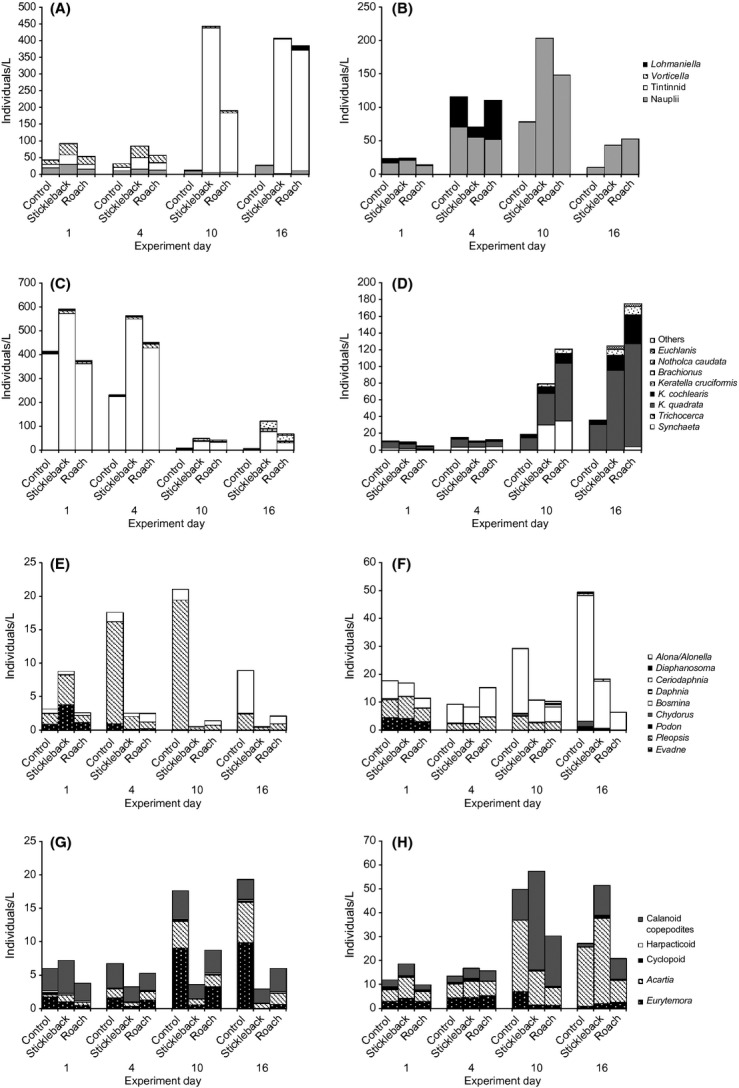
Mean total abundances of zooplankton in each treatment (control, stickleback, roach) on days 1, 4, 10, and 16 of spring (A, C, E, and G) and summer (B, D, F, and H) experiments, showing proportions of species/genera in the community: microzooplankton and nauplii (A, B), rotifers (C, D) cladocerans (E, F), and copepods (G, H). Note different axis scales.